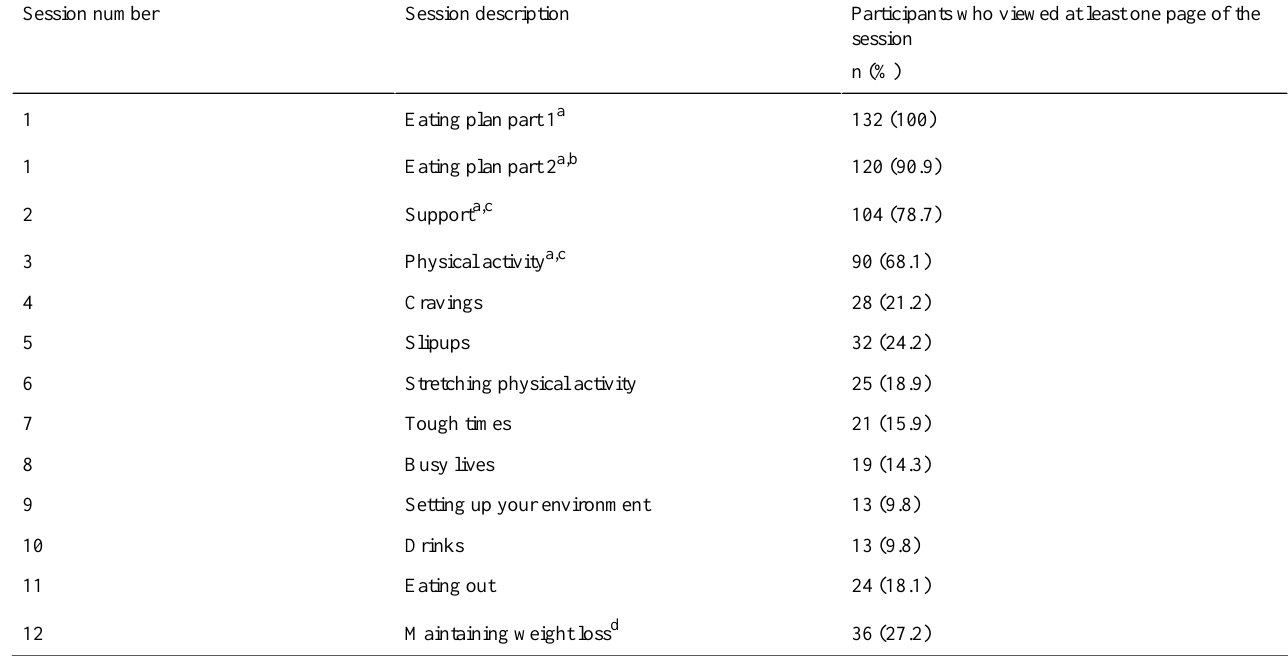
Table 3. Numbers (and percentages) of participants who used the core and optional sessions.